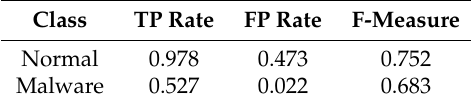
Table 12. Performance of the One-class SVM on the NSL-KDD Test + .